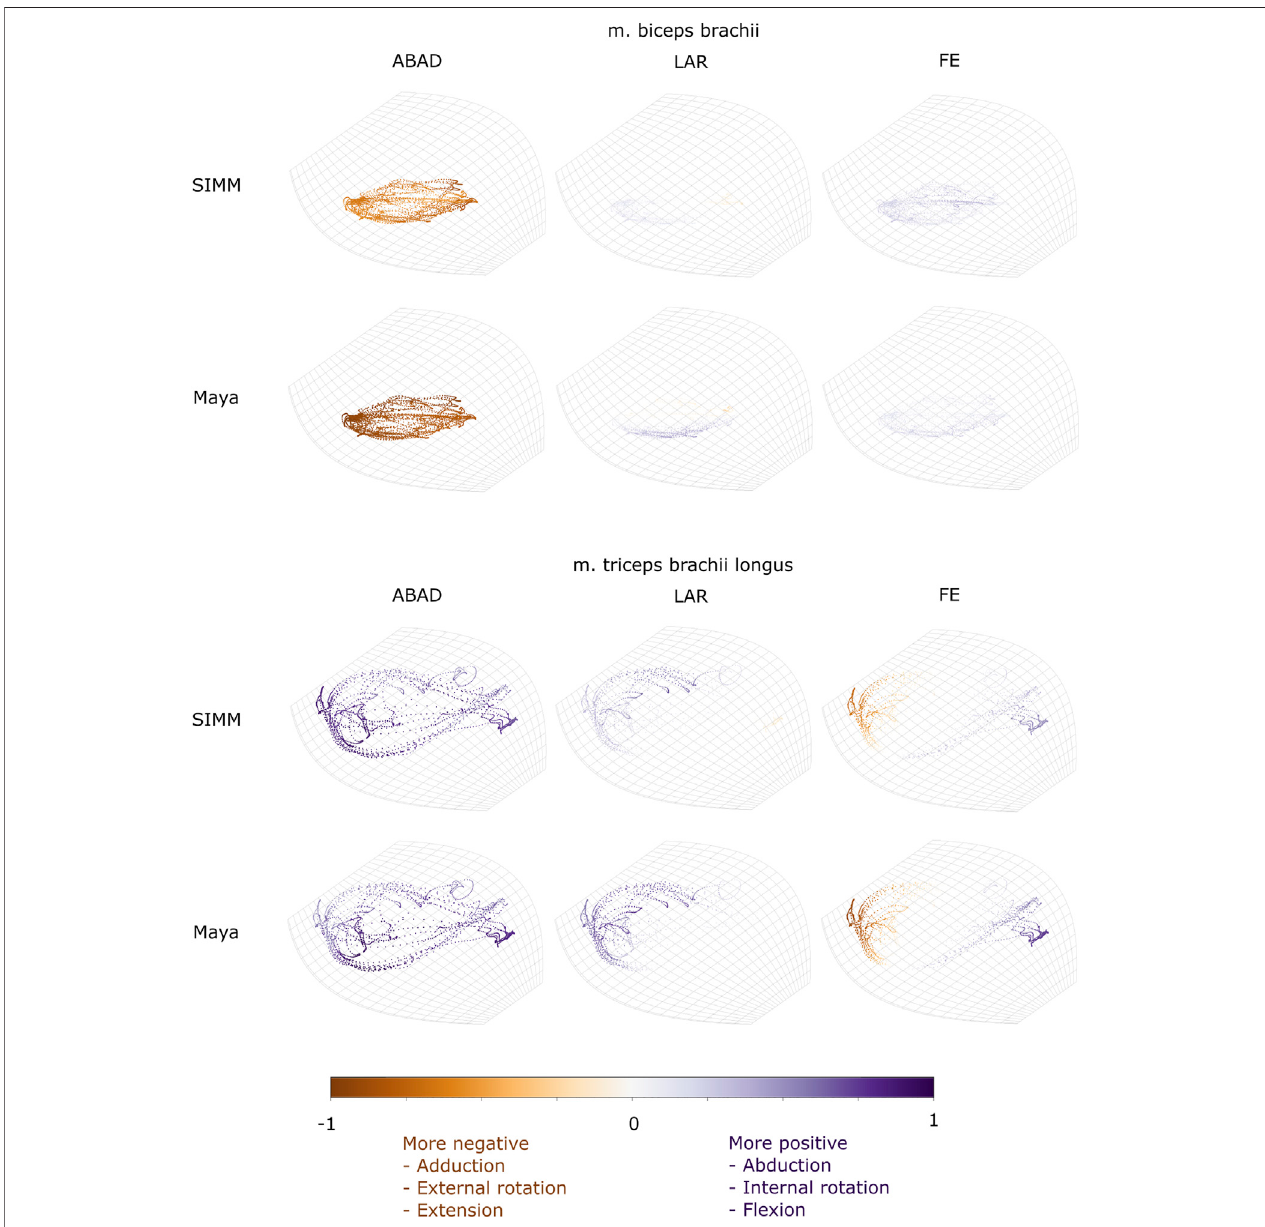
FIGURE 9 | Three-dimensional (3D) MMAs of m. biceps brachii and m. triceps brachii at the glenohumeral joint, plotted in cosine-corrected ROM space for the SIMMmodel(usingpartialvelocity)andMayaexperimentaldata(usingthegeometricmethod).MMAsignisindicatedbypointcolour(positivevaluesarepurple,negative valuesareorange)withcolourintensityscaledtorelativeMMAmagnitudeasdescribedintheMethods.ABAD (cid:3) abduction-adduction;LAR (cid:3) long-axisrotation(internal- external rotation); FE (cid:3) fl exion-extension. Plot for these muscles MMAs at the humeroradioulnar joint can be found in Supplementary Figure S5